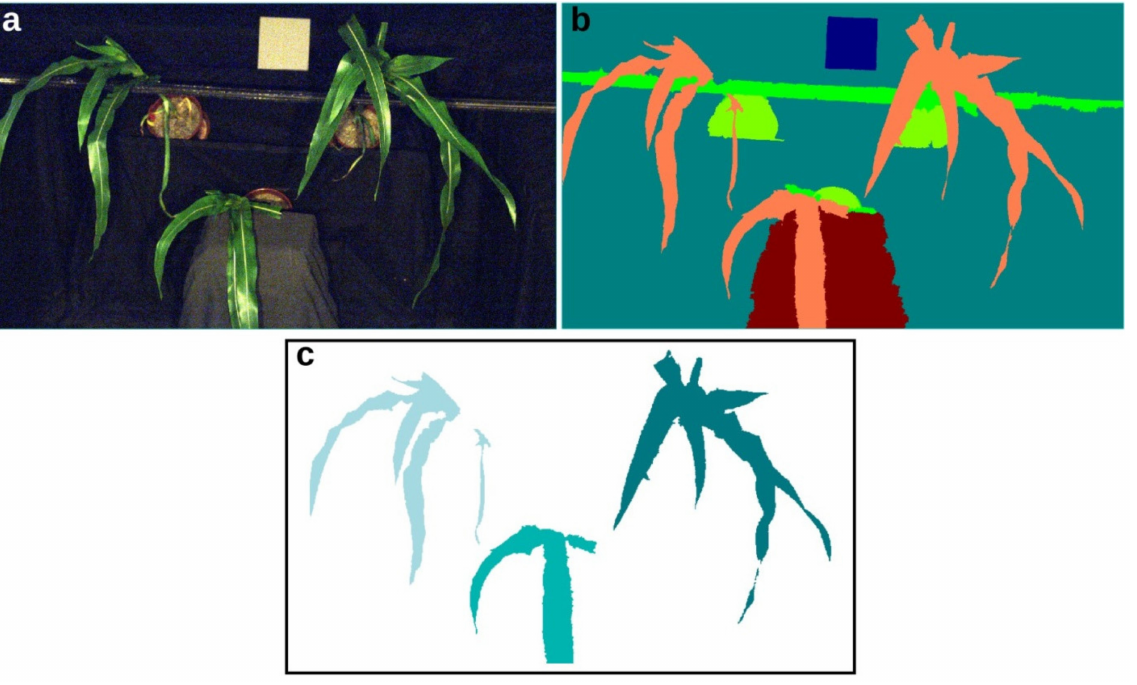
Figure 1. Hyperspectral data analysis pipeline: ( a ) hyperspectral image in radiance units from the VNIR sensor (400–950 nm); ( b ) image segmentation into five classes (plants, reference plate and three classes for background); ( c ) separation into individual